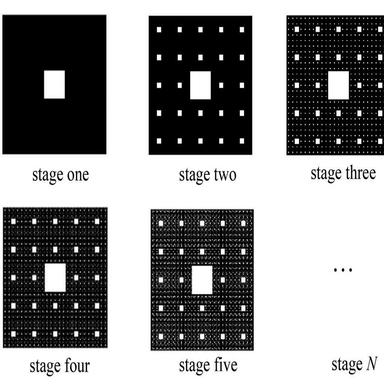
The fractal models of MFs.